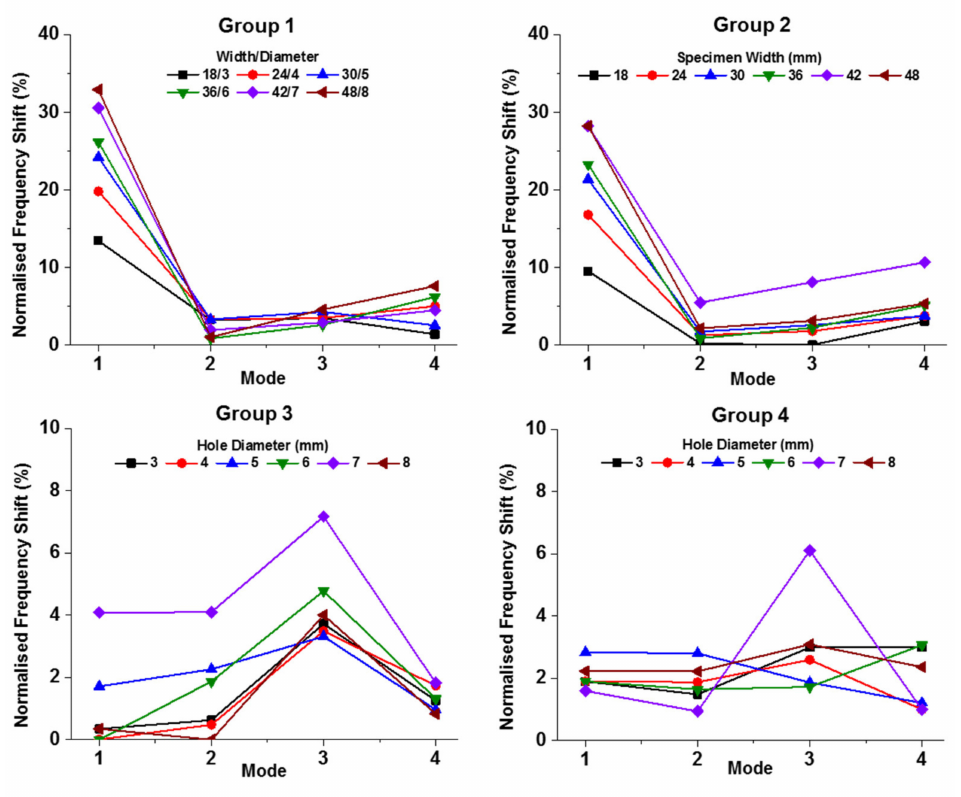
Figure 14. Normalized frequency shifts for samples 2–7 of all groups.